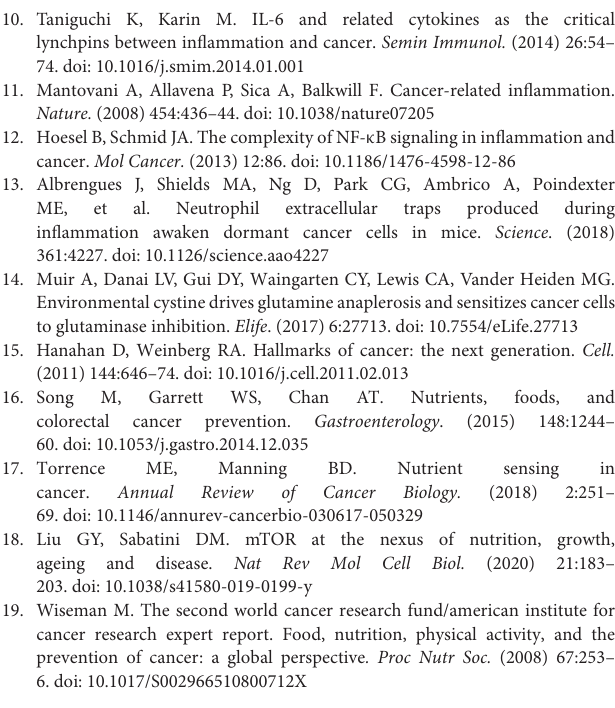
Supplementary Figure 1 | The overall survival (A) and progression-free survival (B) of total patients, patients in training and validation group, respectively. Supplementary Figure 2 | Kaplan-Meier analyses and log-rank tests of pyrexia before surgery in OS (A) p = 0.530 and PFS (B) , p = 0.600, pyrexia after surgery in OS (C) p = 0.430 and PFS (D) p = 0.003, hyperpyrexia before surgery in OS (E) p = 0.200 and PFS (F) p = 0.730, hyperpyrexia after surgery in OS (G) p = 0.240 and PFS (H) p = 0.900 in training group, respectively. Supplementary Figure 3 | Time-dependent (5-year) calibration plots in training group (A) and validation group (B) . Time-dependent decision curve analysis (DCA) curves in training group. (C) , 3-year; (D) , 5-year. Supplementary Figure 4 | Time-dependent ROC curves and AUC of different prognostic models in training and validation group. (A) 3-year, training group; (B) 5-year, training group; (C) 3-year, validation group; (D) 5-year, validation group. Supplementary Figure 5 | Kaplan-Meier analyses and log-rank tests of patients in BLR and AGR subgroup stratified by scope of surgery. (A,B) high-level of AGR; (E,F) low-level of AGR; (C,D) high-level of BLR; (G,H) low-level of BLR. (A,C,E,G) overall survival (OS); (B,D,F,H) progression-free survival (PFS). Supplementary Table 1 | Univariate and multivariate COX regression analysis of progression-free survival in training group. Supplementary Table 2 | Univariate and multivariate COX regression analysis of overall survival in training